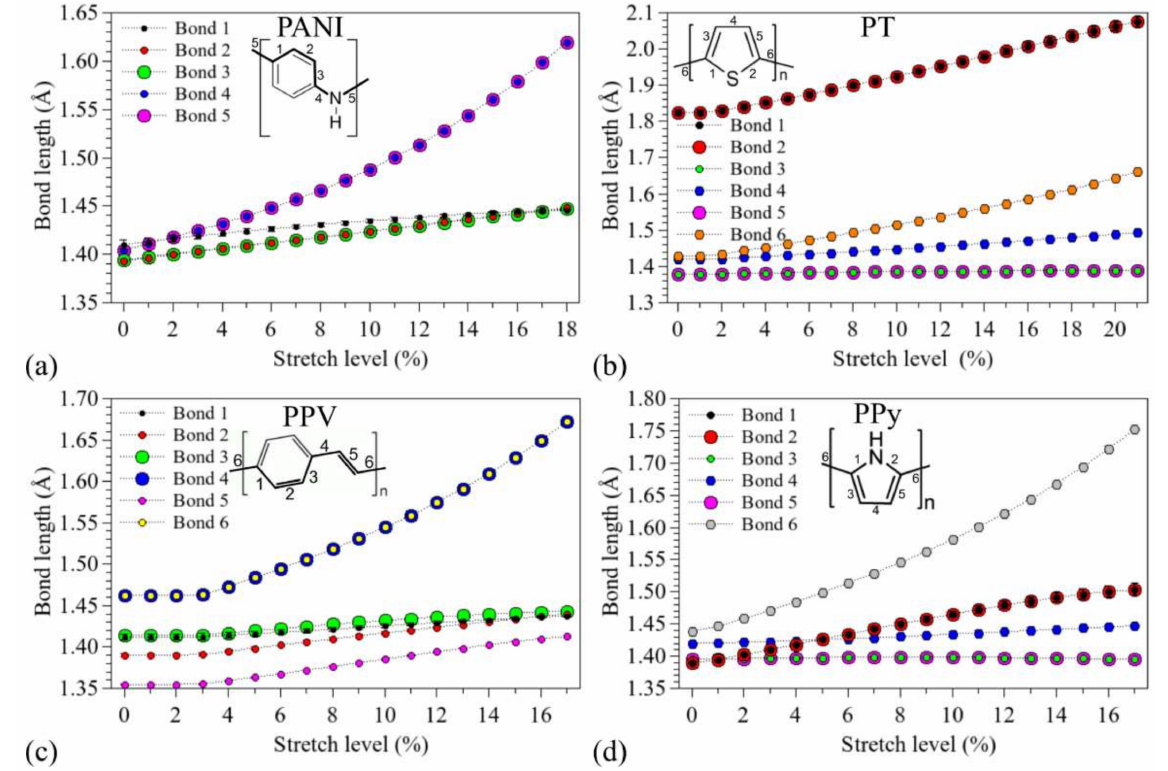
Figure 3. Changes in the oligomer bond lengths during the stretching processes: ( a ) PANI, ( b ) PT, ( c ) PPV, and ( d ) PPy.